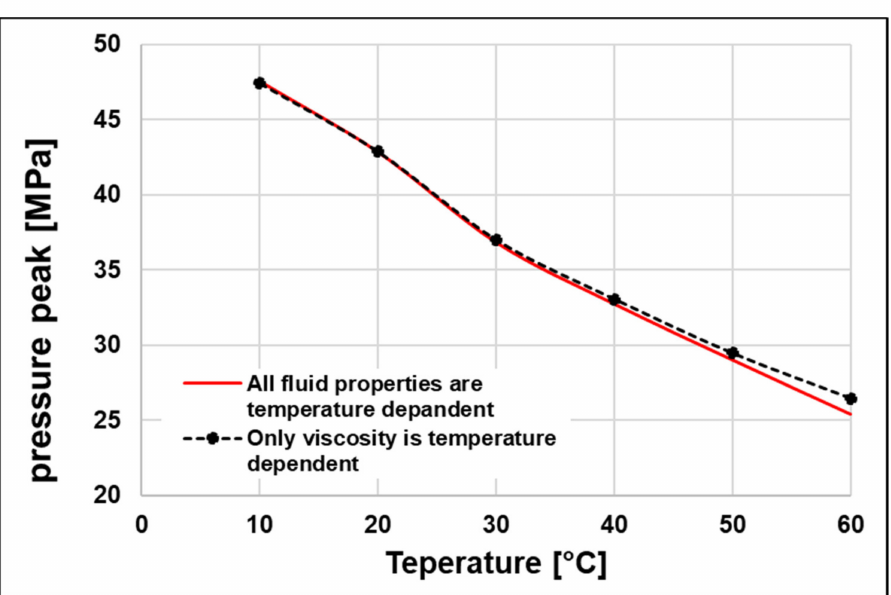
Figure 27. Comparison of the pressure peaks values predicted using a model in which only viscosity was temperature dependent and model in which all fluid properties were temperature